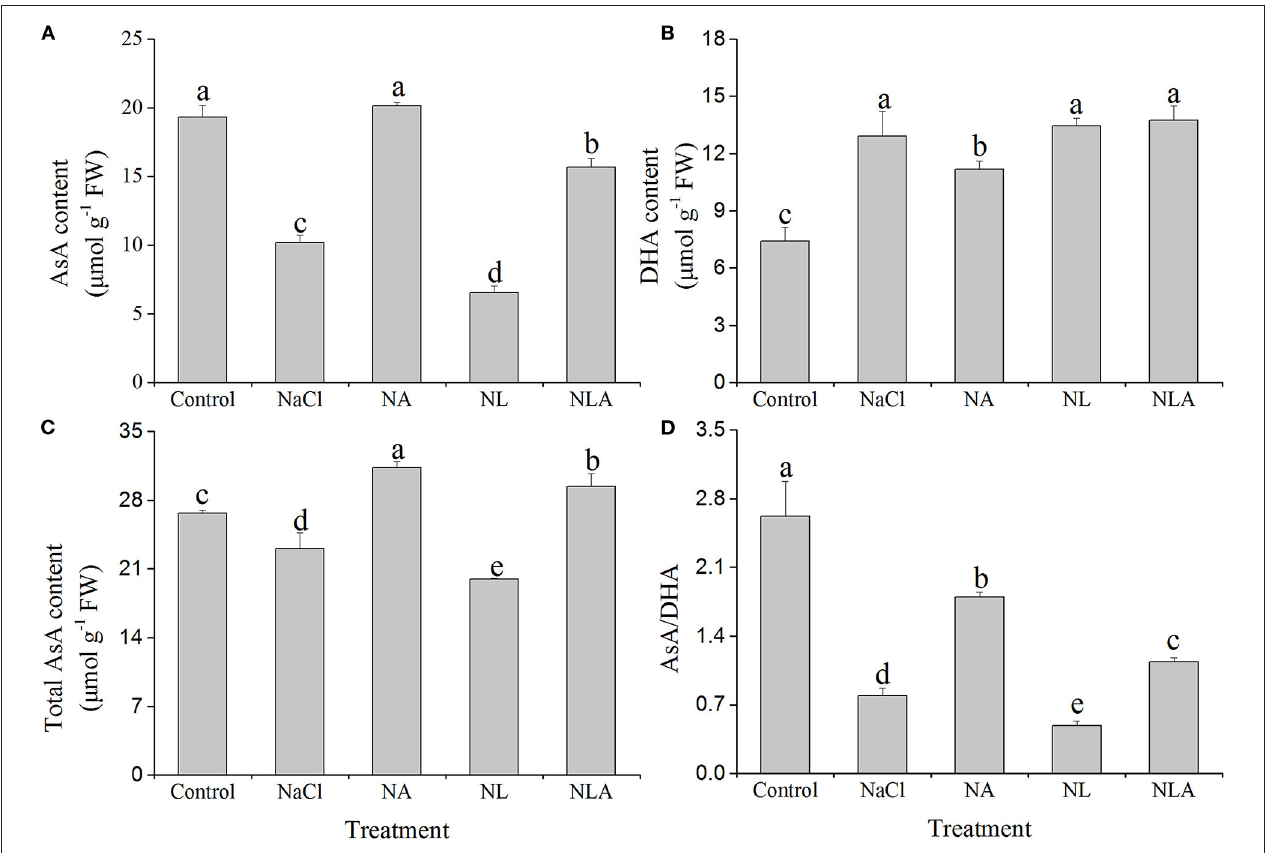
FIGURE 2 | Values of ascorbic acid (AsA) content (A) , dehydroascorbate (DHA) content (B) , total AsA content (C) , and AsA/DHA (D) in the leaves of salt-stressed tomato seedlings with or without exogenous AsA and lycorine (LYC) spraying. Values are means ± SD ( n = 3). Different letters (a, b, c, d, and e) indicate significant difference at P < 0.05 among treatments. Control, no added NaCl, no sprayed AsA and LYC; NaCl, added 100 mmol/L NaCl; NA, added 100 mmol/L NaCl and sprayed 0.5 mmol/L AsA; NL, added 100 mmol/L NaCl and sprayed 0.25 mmol/L LYC; NLA, added 100 mmol/L NaCl and sprayed 0.25 mmol/L LYC and 0.5 mmol/L AsA.